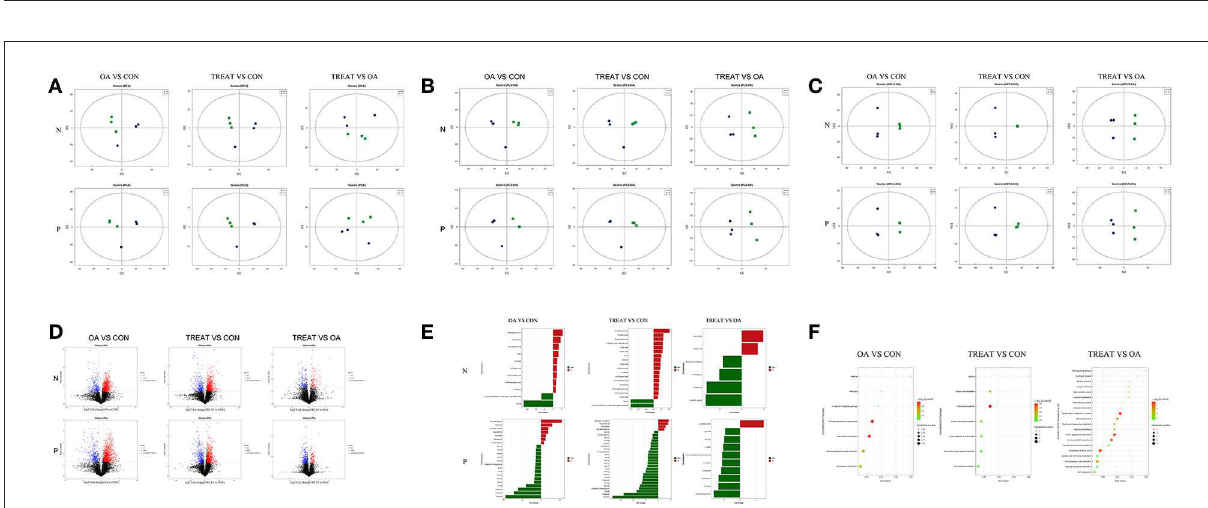
FIGURE4 Effects of the oral administration of live combined Bacillus subtilis and Enterococcus faecium on the metabolite analysis of the feces of OA rats. (A) Score plot of PCA. (B) Score plot of PLS-DA. (C) Score plot of OPLS-DA. (D) Volcano plot shows the number of dysregulated metabolites. (E) Differential metabolites. (F) Differential metabolic pathway ( n =